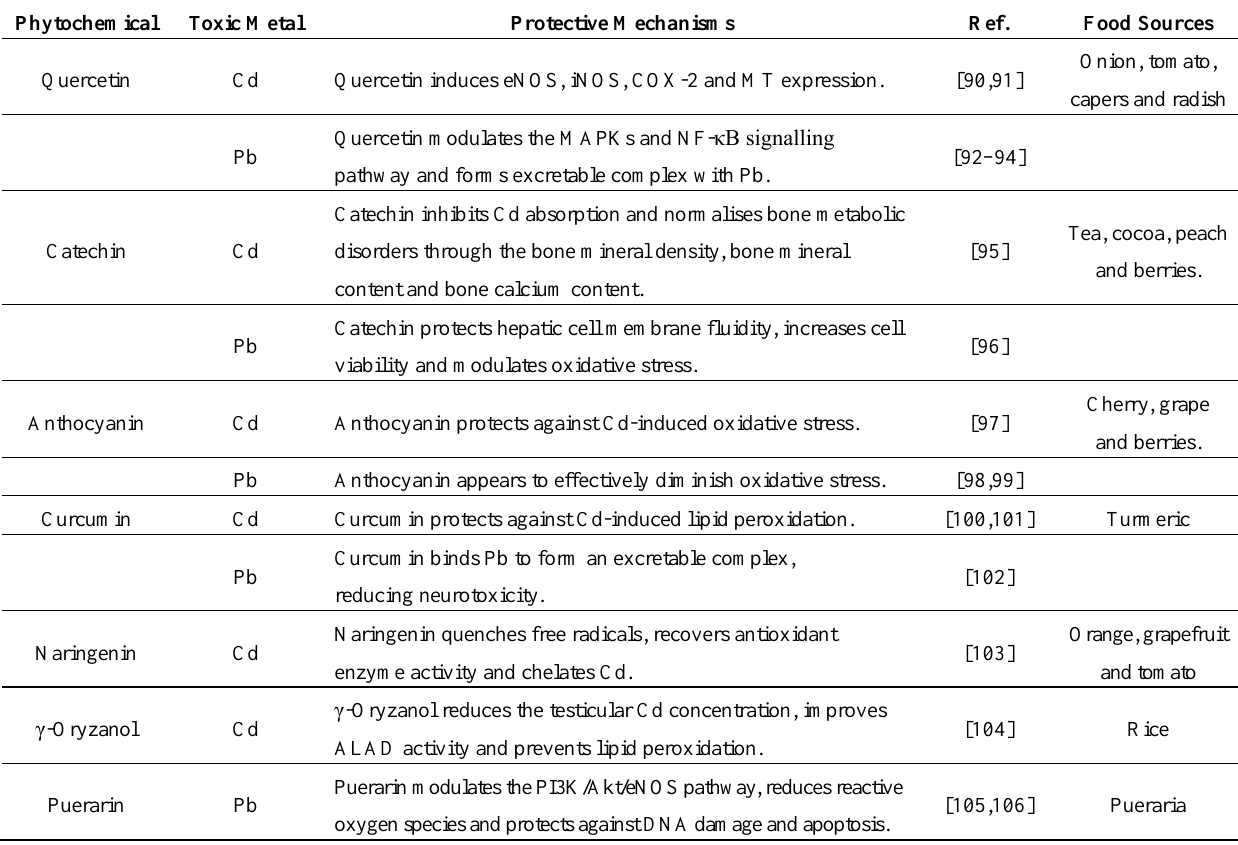
Table 3. Protective mechanisms of phytochemicals against Cd and Pb toxicity and their food sources. Phytochemical Protective Mechanisms Ref. Food Sources